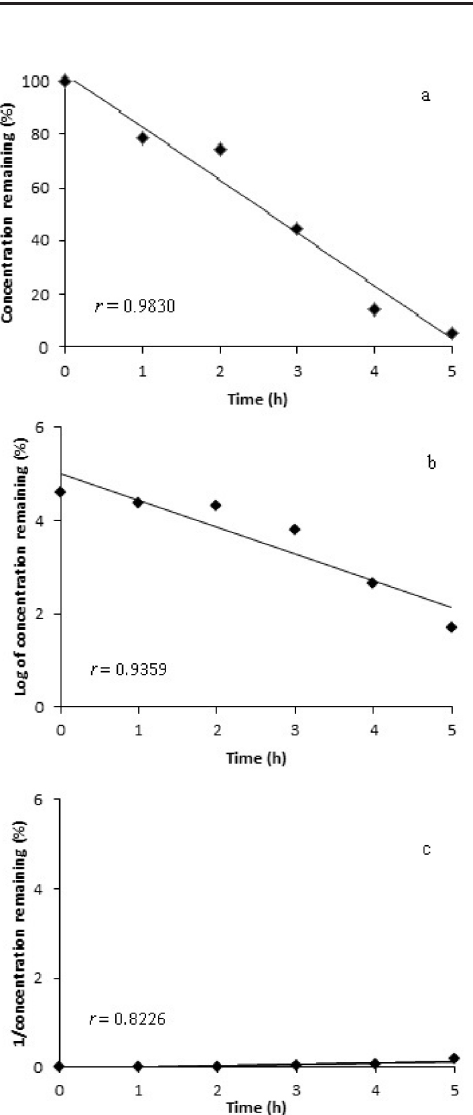
FIGURE 4 - Plots of concentration (a)- zero-order reaction, log of concentration (b)- first-order reaction, and reciprocal of concentration (c)- second-order reaction of BD remaining versus